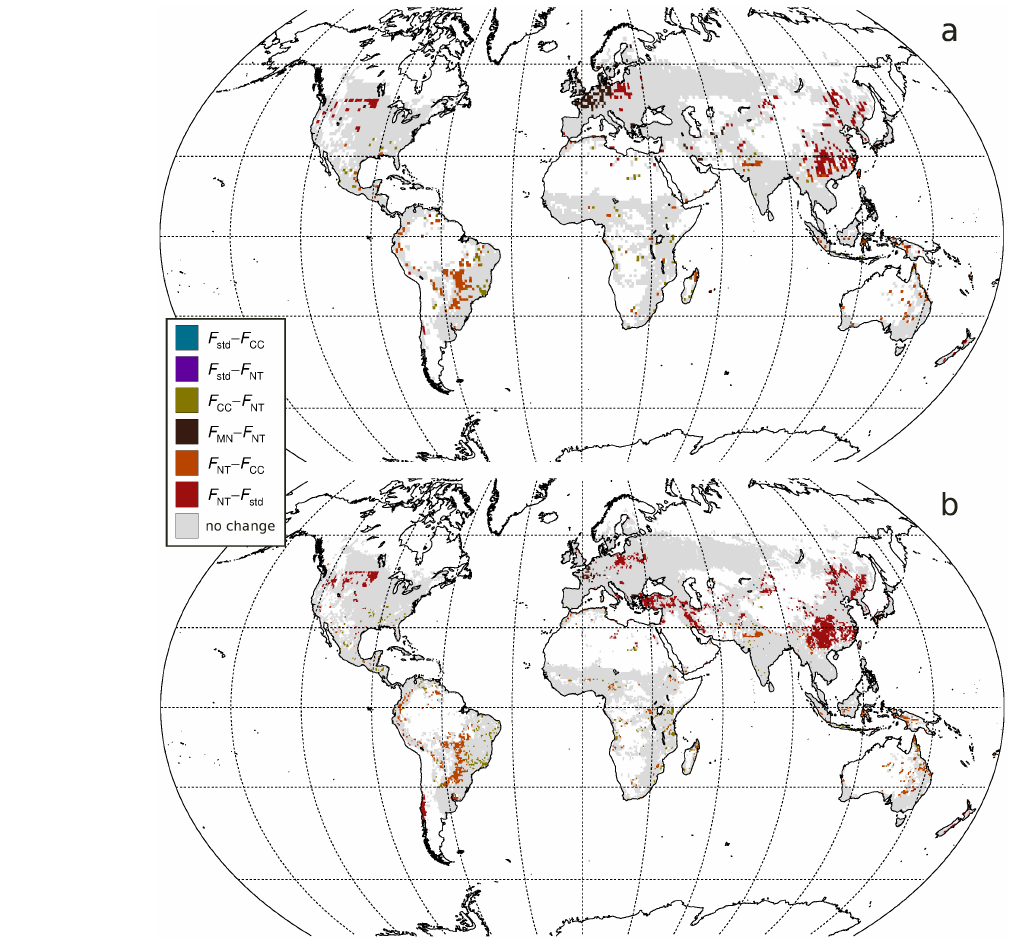
Figure 6. Grid cells where different management options resulted in the highest soil carbon in 2000 (Fig. 4) compared to 2050: (a) RCP2.6 and (b) 8.5. Grid cells with no cropland in the input data set are shown in